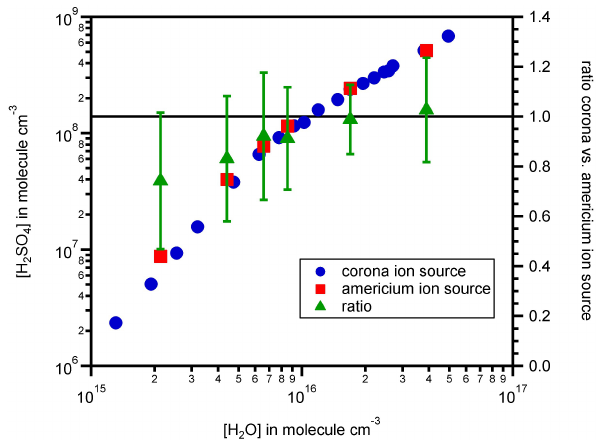
Fig. 3. Measured H 2 SO 4 concentrations when operating the CIMS instrument with an americium and with a corona ion source, respec- tively. Different H 2 SO 4 concentrations were adjusted by a calibra- tion system. These are a function of [H 2 O] shown on the x-axis. Error bars for the H 2 SO 4 values have been neglected for clarity. The main error for the ratios between the values for the corona and the americium ion source comes from the uncertainty in the tem- perature measurement (which is assumed to be ± 1 ◦ C). This error in temperature affects the conversion from relative humidity into concentration of H 2 O strongly due to the dependence of the water vapor saturation pressure on